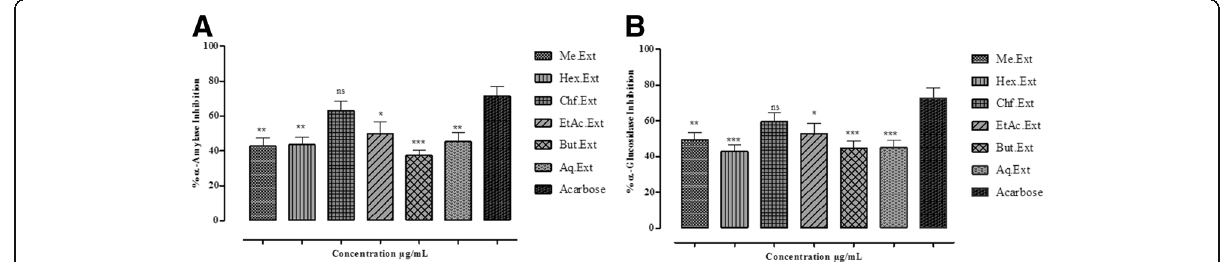
Fig. 4 a % α -amylase b α -glucosidase inhibition potential of E. umbellata fruit Me-Ext and subsequent fractions at various concentrations. The data is represented as Mean ± SEM, n = 3. Values are significantly different as compared to positive control (* P < 0.05, ** P < 0.01, *** P <